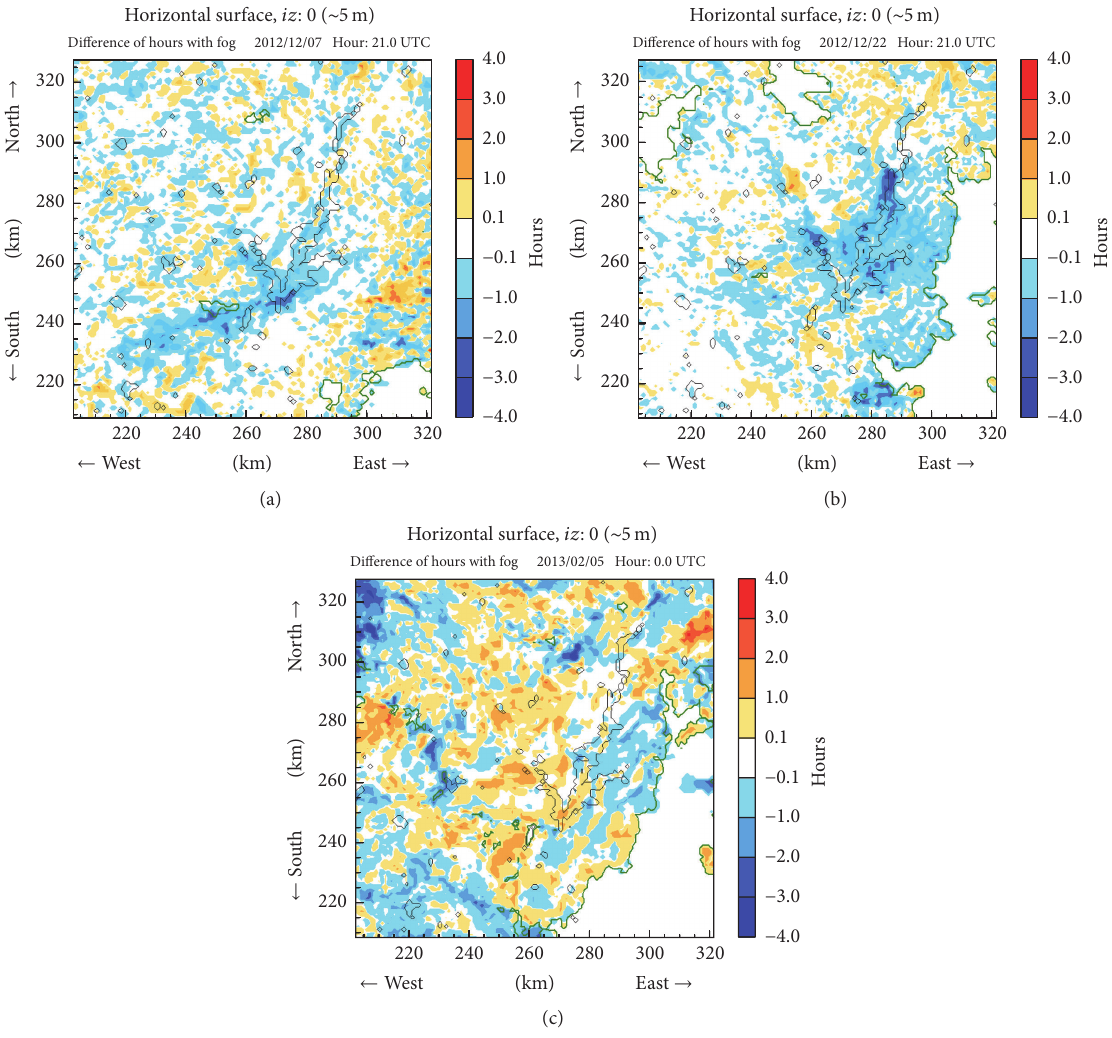
Figure 16: Difference between the “number of hours with fog” of simulations, with and without Alqueva from 21:00 to 15:00 UTC in D2 domain. Fog occupation boundaries with Alqueva (green line), color scale (Alqueva, original). (a) 2012/12/08, (b) 2012/12/23, and (c)